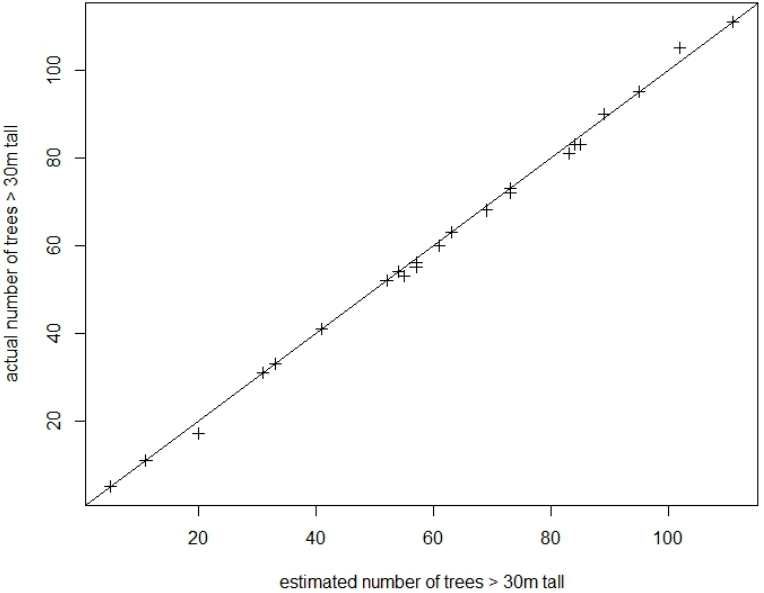
Figure 5. Number of tall trees within each land component as identified in stereo-imagery (actual) versus the number of tall trees as identified by the automated tree mapping algorithm (estimated).